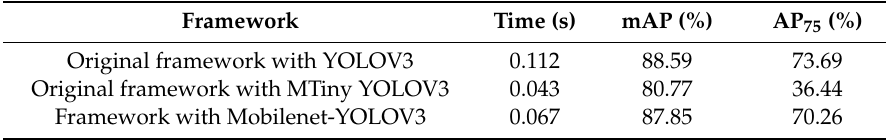
Table 3. Results of the frameworks with di ff erent networks in the fine-grained detection